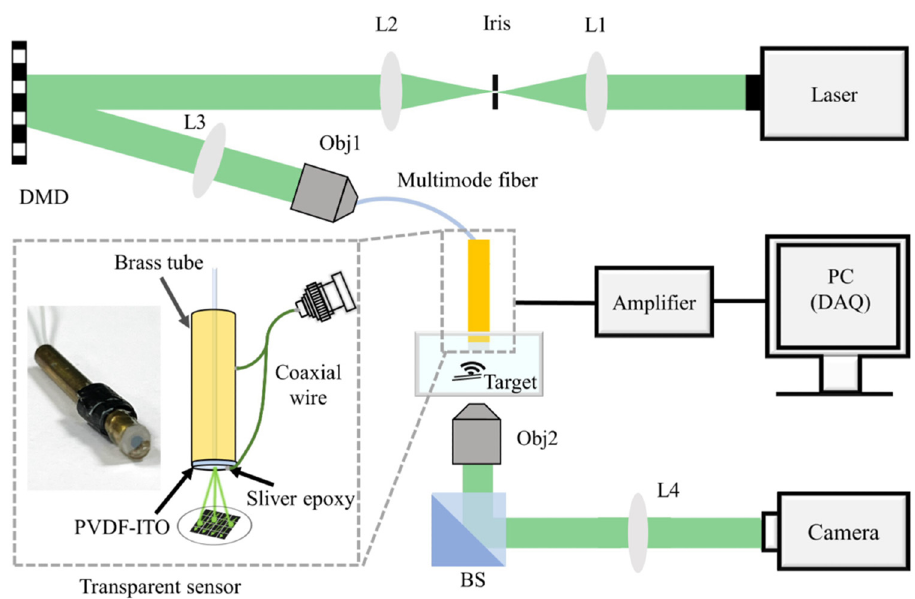
Figure 1. Schematic diagram of the photoacoustic endomicroscopy imaging system. The inset shows a photograph and a schematic of the transparent ultrasound sensor. DMD, digital micromirror device; L1–L2, convex lens (f = 50 mm); L3–4 convex lens (f = 100 mm); Obj1–2, objective lenses; BS, beamsplitter; DAQ, data acquisition